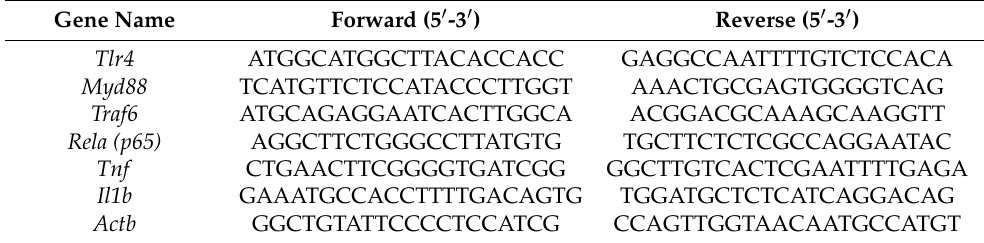
Table 1. The primers for